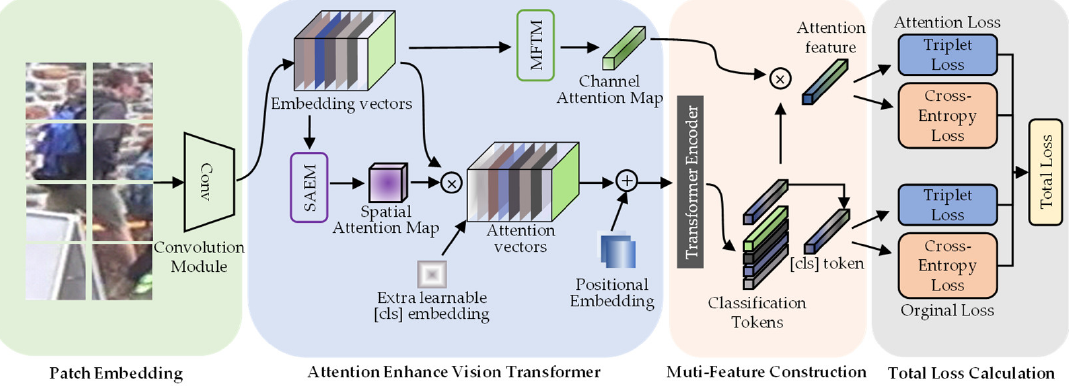
Figure 4. Framework of proposed AET-Net. SAEM changes the state of the spatial distribution of embedding vectors by extracting spatial attention maps (blue). MFTM optimizes the network by constructing multiple features and calculating multiple losses (yellow and gray).